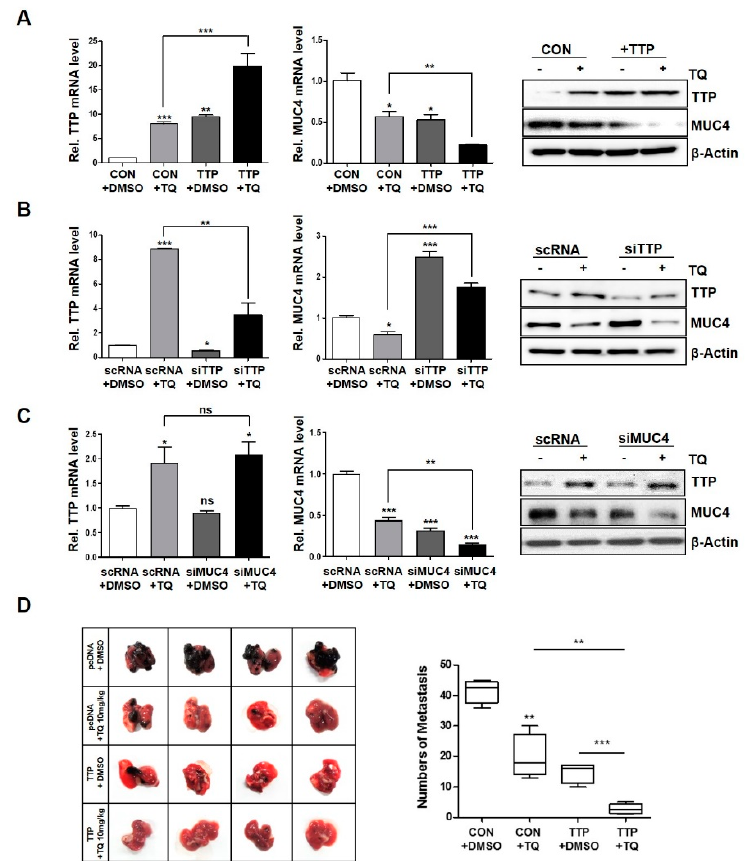
Figure 6. TQ-induced TTP reduced cancer metastasis in vivo. ( A ) TQ treatment and TTP overexpression reduce MUC4 expression in B16F10 cells. Cells were transfected with pcDNA (control; CON) or TTP ( + TTP overexpression vector), exposed to TQ, and the expression of TTP and MUC4 was examined in these cells. After 24 h, mRNA and protein levels were analyzed using qRT-PCR (left panel) and western blotting (right panel). ( B ) Suppression of TTP by siTTP increased mRNA and protein levels of MUC4 in B16F10 cells. Cells were transfected with scRNA or siTTP and then exposed to TQ, and expression levels were analyzed by qRT-PCR and western blotting. ( C ) Cells were transfected with scRNA or siMUC4 and then treated TQ, and expression levels were analyzed by